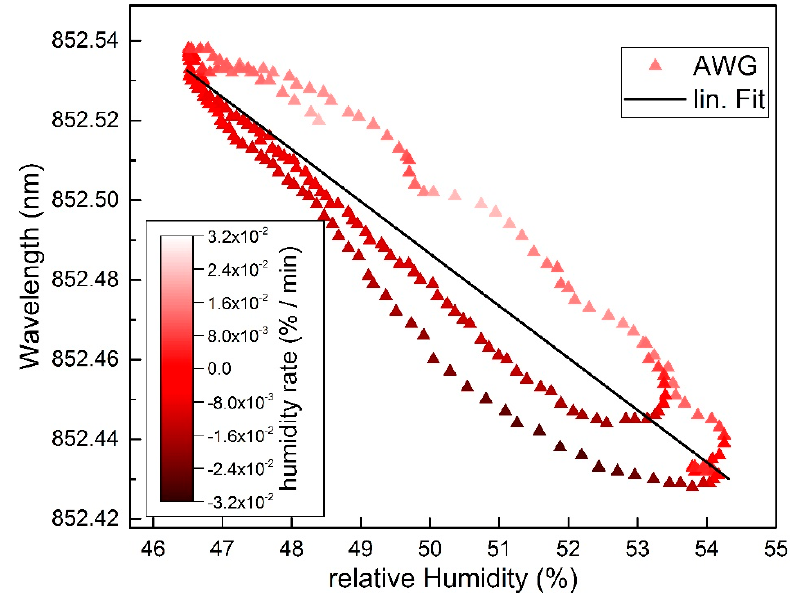
Figure 6. FBG wavelength measured by the AWG during the isothermal period of the temperature experiment shown in Figure 5. In the relevant humidity range there is a linear correlation between the optical output of the AWG and the relative humidity.